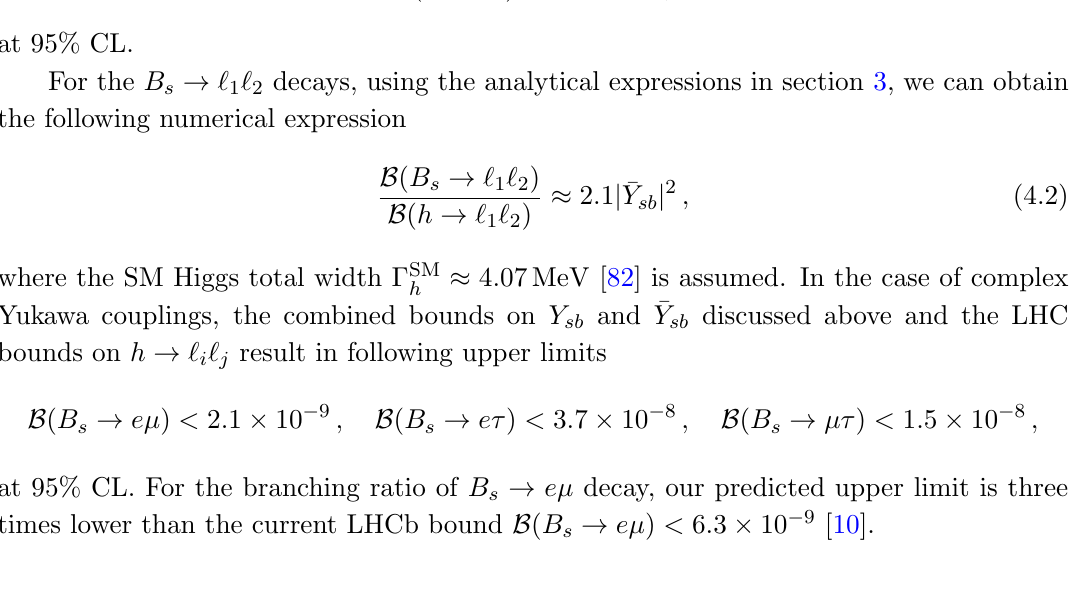
; 0). In the dark region, (cid:22)(cid:22)